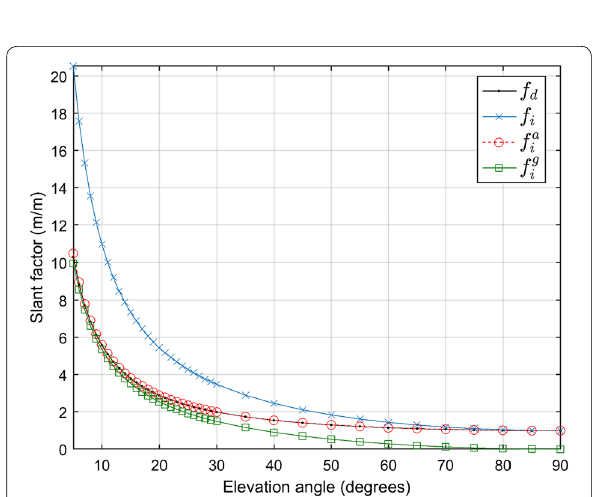
Fig. 8 Slant factors for the direct and interferometric—total and components—signals as a function of satellite elevation angle (for a fixed 10‑m reflector